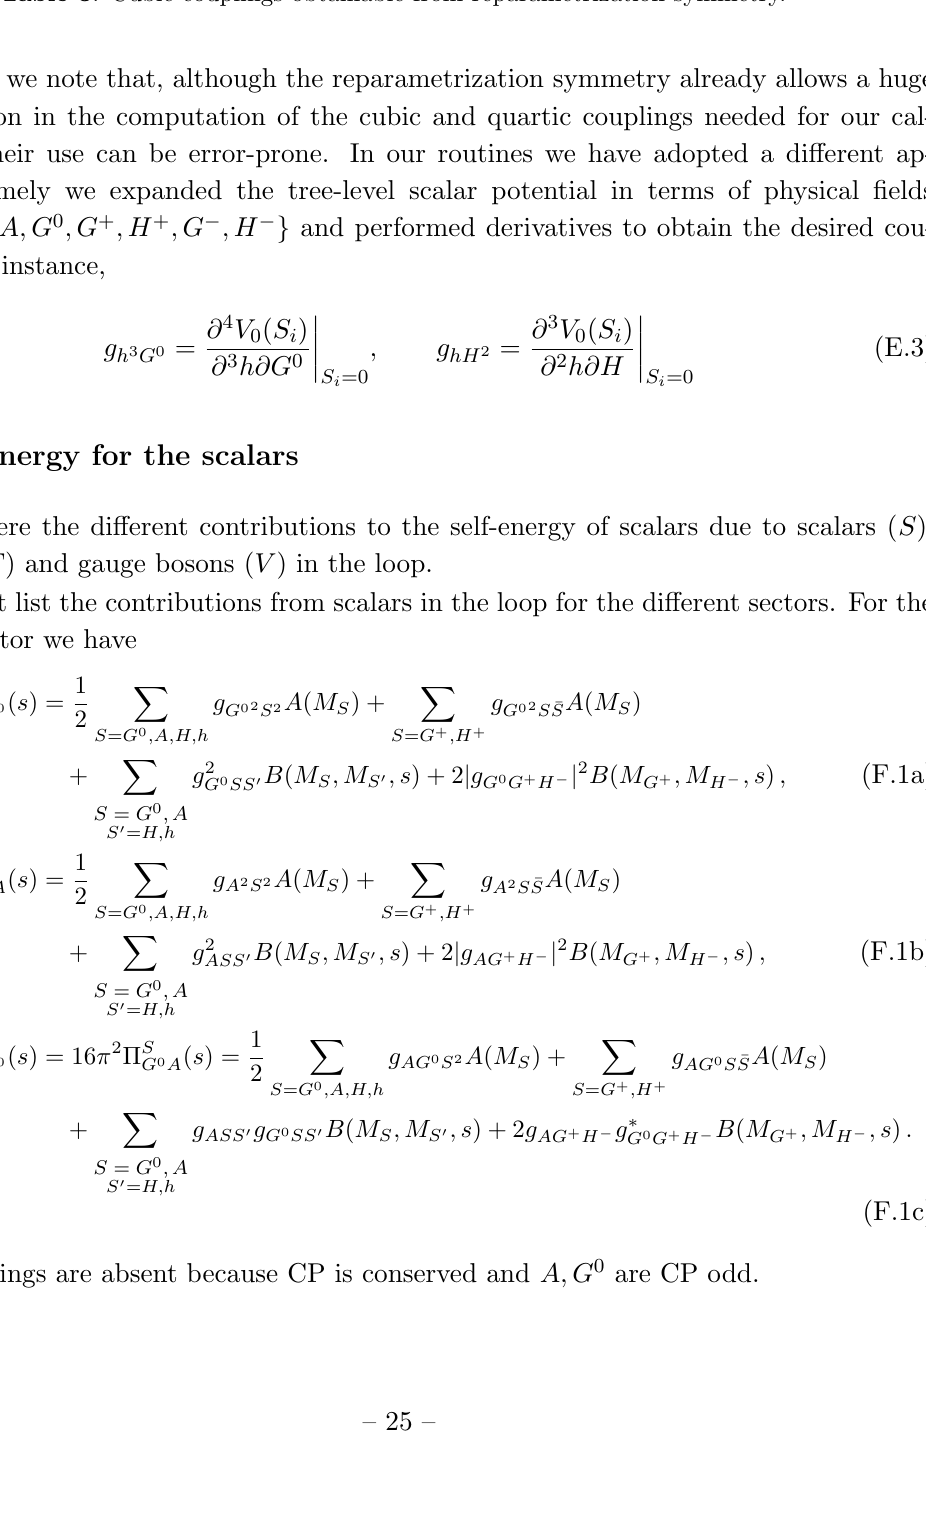
Table 3 . Cubic couplings obtainable from reparametrization